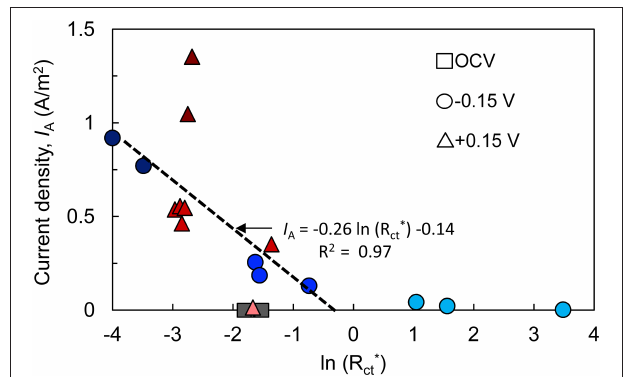
FIGURE 4 | Relationship between bioanode charge transfer resistance (R * ct ; normalized to each bioanode’s resistance prior to introducing microorganisms) and current density ( I A ). Both metrics were recorded at the end of the startup cycle. Points with the same shape represent replicate bioanodes fixed at − 0.15V (circles) and + 0.15V (triangles). The points are shaded to reflect bioanode activity level (dark, high-activity; medium, low-activity; light, inactive). OCV, open circuit voltage bioanodes (squares). The linear regression of high- and low-activity bioanode points at − 0.15V is shown as a dashed line.